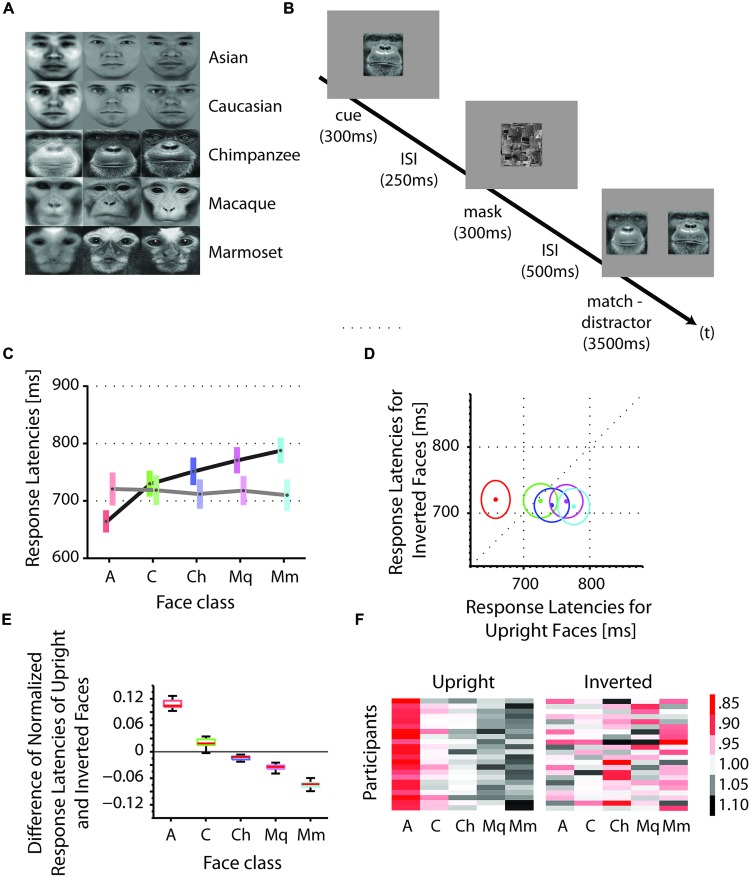
Stimuli, procedure and reaction times, and configural analysis. (A) Stimuli: identities (horizontal) and classes (vertical). (B) Procedure. In each trial, a face picture of an individual (cue) was centrally presented on the display for 300 ms, followed by an inter stimulus interval (ISI) of 250 ms, followed by a mask for 300 ms, followed by a second ISI of 500 ms and a presentation of two horizontally aligned face pictures of the same individual (match) and a different individual (distractor). Participants indicated their choice by pressing one of two buttons on the joystick, corresponding to the left and right stimulus on the screen. The correct answer (match) is the identical face picture as shown in the cue stimulus. (C) Absolute reaction times were averaged across participants for each face class (A, Asian; C, Caucasian; Ch, chimpanzee; Mq, macaque; Mm, marmoset). The color bars indicate the range within the standard errors; the gray dots indicate the means. Reaction times for upright faces are shown in darker colors; those for inverted faces in lighter colors. (D) Absolute reaction times of upright versus inverted faces. Mean reaction times for upright and inverted faces are shown as dots. Colors correspond to the colors in (C). Circles indicate the standard errors. (E) Differences of normalized reaction times of upright and inverted faces. Reaction times were normalized for each face class by the mean of the corresponding class. Scores for upright faces were subtracted from those of inverted faces for each face class. Positive values indicate an advantage for upright above inverted faces in terms of discrimination speed, while negative values indicate an advantage for inverted above upright faces. (F) Normalized reaction times for each participant. The color code represents the relative reaction times, with red being fast, black being slow and white intermediate. Values above zero indicate slower responses than the mean response (= 0); values below zero indicate faster responses than the mean response.